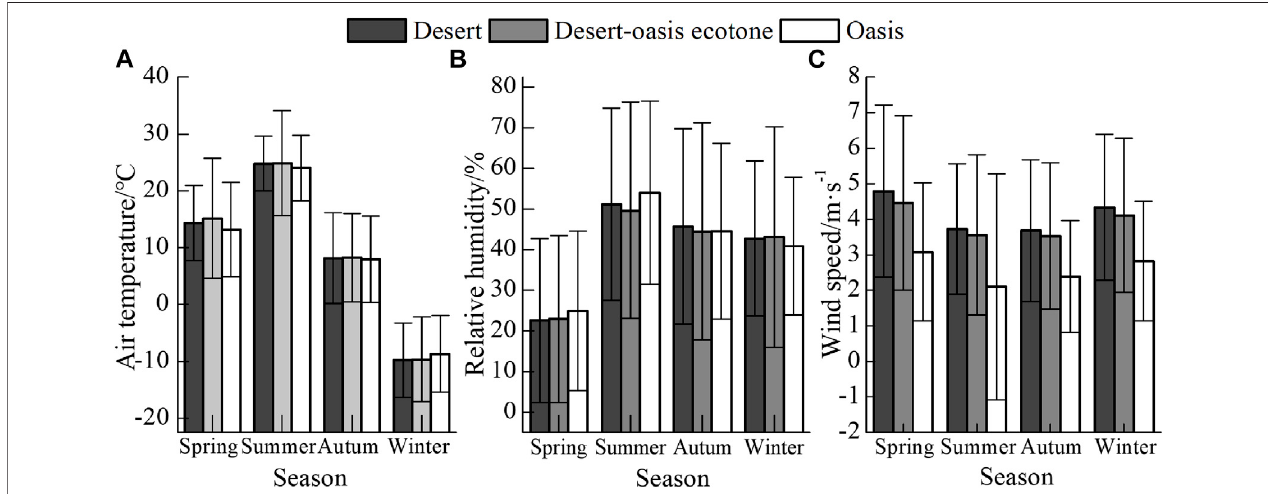
FIGURE 6 | Seasonal variations of (A) air temperature, (B) relative humidity, and (C) wind speed.